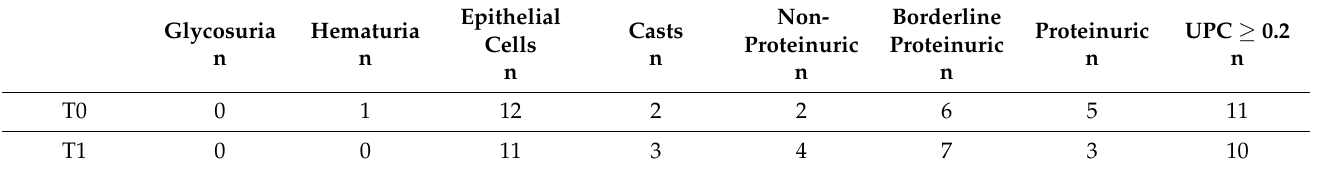
Table 3. Results of urinalysis in dogs before (T0) and after (T1) IVIC administration *.